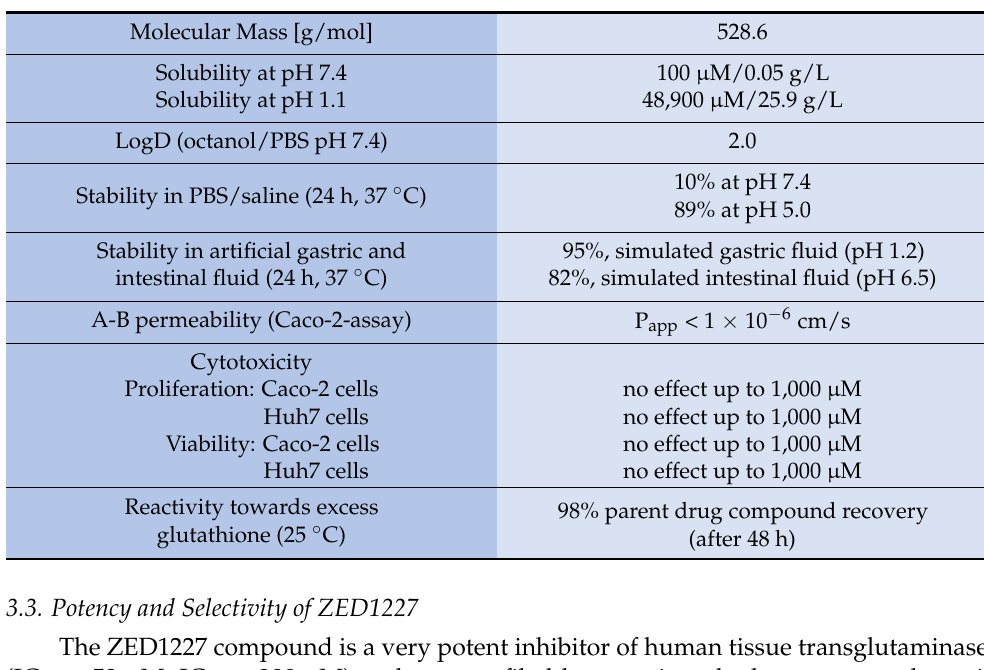
Table 1. In vitro profiling of ZED1227.